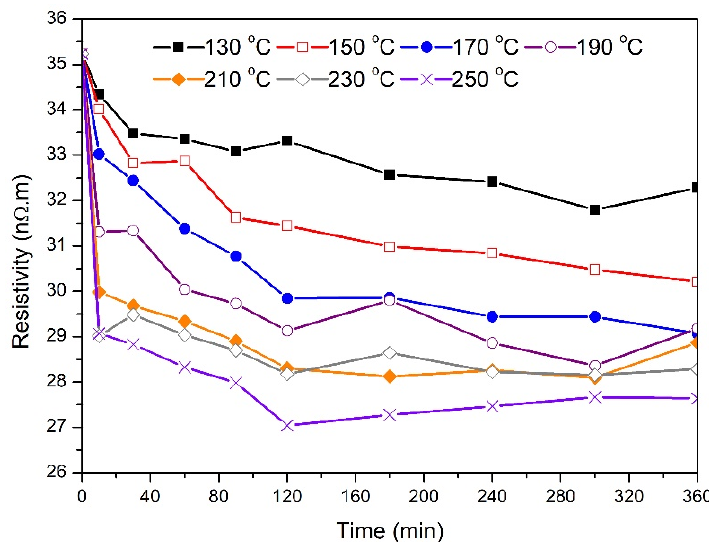
Figure 5. Changes in electrical resistivity as a function of the annealing time for 3.5 mm samples at the specified temperature.